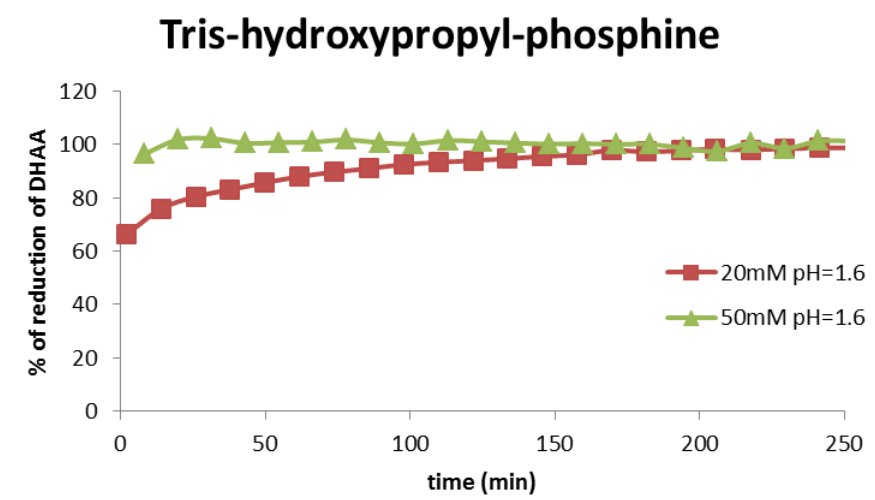
Figure 2. Degree of reduction in dehydroascorbic acid versus time, with the use of tris-hydroxypropyl-phosphine.